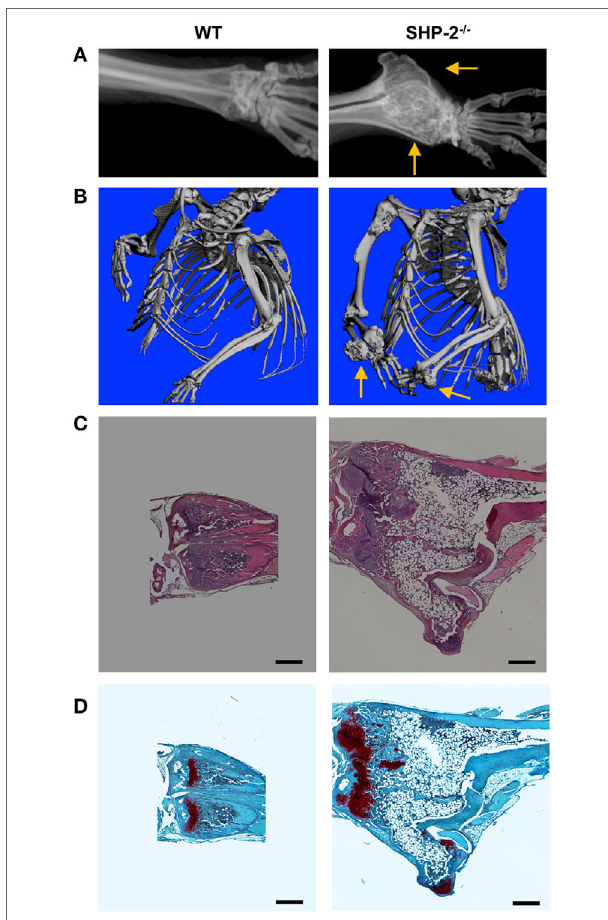
FigUre 4 | SHP-2 − / − mice develop cartilage tumors. (a) Representative Faxitron X-ray of euthanized mice, 9 months of age. Arrows highlight the location of the wrist. (B) Representative microcomputed tomography ( μ -CT) analysis shows the wrist tumor in SHP-2 − / − mice at 9 months of age. (c) Representative hematoxylin and eosin staining of distal radius of 6-month-old mice. (D) Representative Safranin-O/Fast Green staining of distal radius of 6-month-old mice reveals abnormal cartilaginous regions within the wrist tumor of SHP-2 − / − mice. Each analysis was performed on at least three mice per genotype. Scale bar represents 500